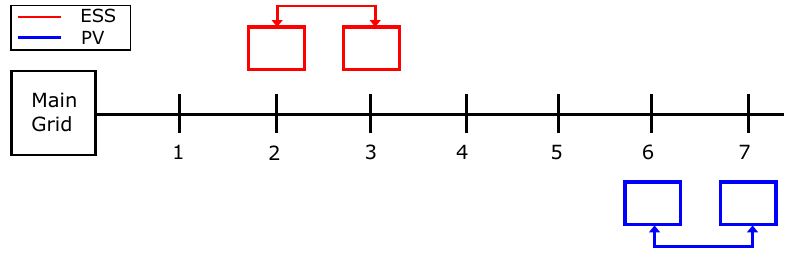
Figure 2. LV grid without virtual nodes.